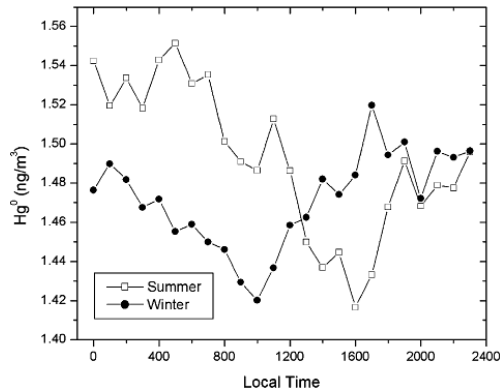
Figure 3. Figure 7 from Weiss-Penzias et al. (2003). Reprinted with permission from Weiss-Penzias et al. (2003), copyright: 1 Septem- ber 2003 American Chemical